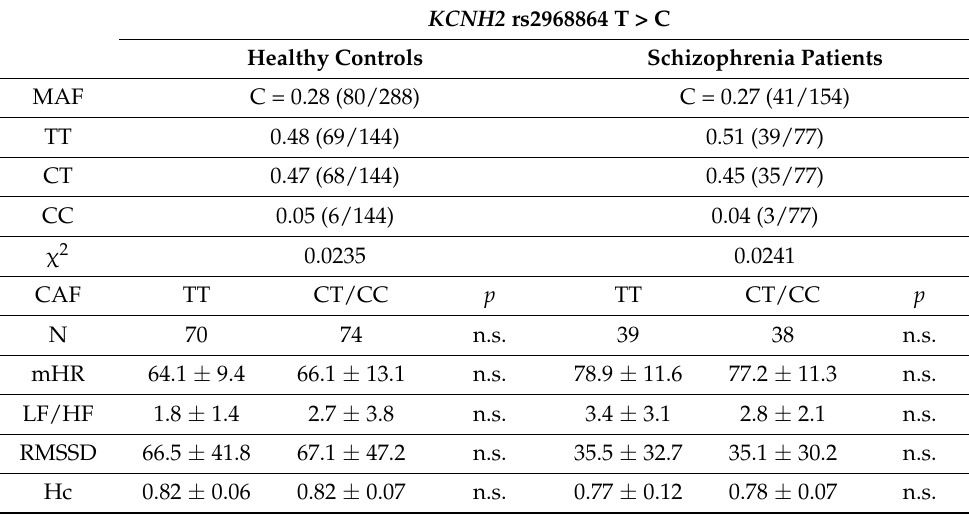
Table 4. Main Effect of KCNH2 Genotype Risk on Cardiac Autonomic